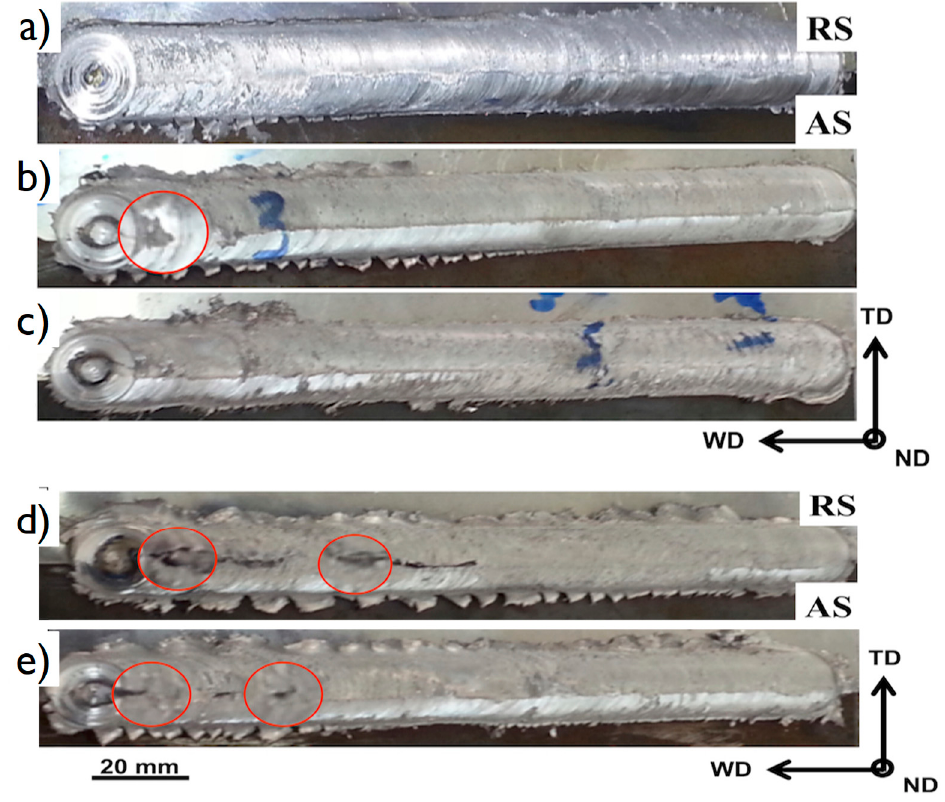
Figure 3. Top surface appearance along the joint line for the FSWed aluminum alloy AA2024 and carbon steel 1018 joints at different welding conditions: ( a ) 250 rpm and 25 mm/min; ( b ) 250 rpm and 50 mm/min; ( c ) 250 rpm and 75 mm/min; ( d ) 200 rpm and 50 mm/min; and ( e ) 300 rpm and 50 mm/min.